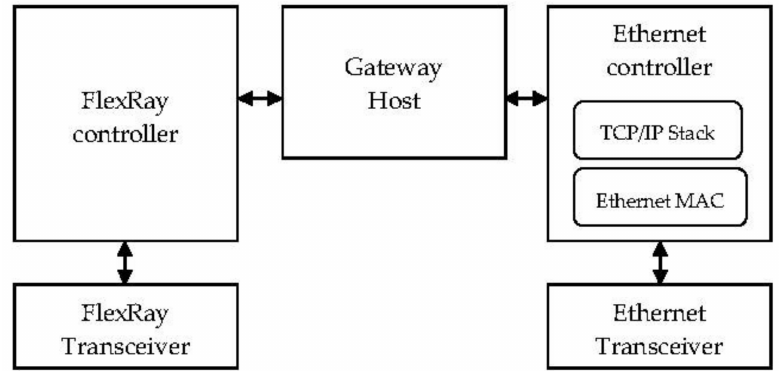
Figure 1. An overview of the implemented system. TCP / IP is transmission control protocol / internet protocol.